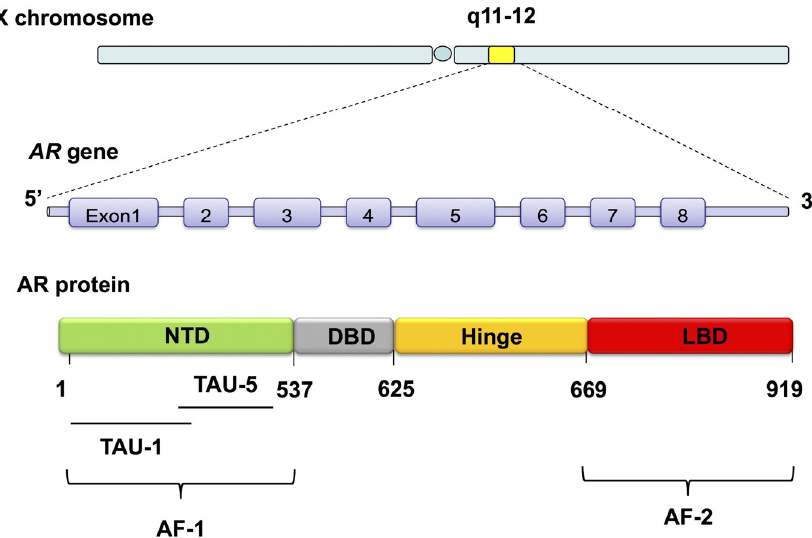
Figure 2. Schematic representation of the androgen receptor (AR) gene and protein, with indications of its specific motifs and domains. The AR gene is located on human X chromosome and is composed of 8 exons. The domains and motifs in the AR protein include: the N-terminal domain (NTD), the DNA-binding domain (DBD), the hinge region, and the ligand-binding domain (LBD), as well as the activation function 1 (AF-1) domain and the activation function 2 (AF-2) domain, and two transcription activation units (TAUs): TAU-1 and TAU-5.